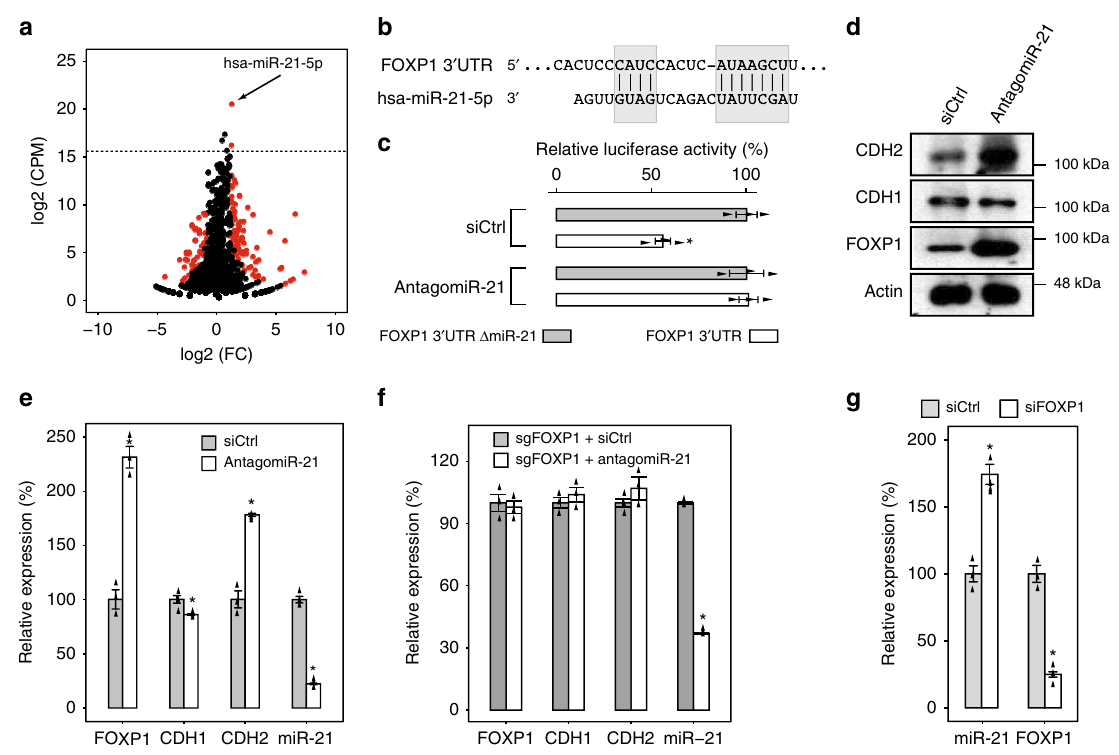
Fig. 2 FOXP1 and miR-21 form a double-negative feedback loop. a Volcano plot showing the differential expression of miRNAs at 96 h into TGF- β -induced EMT in A549 cells. The red dots represent miRNAs with a differential expression FDR < 0.05 and absolute log2-fold change> 1. The horizontal dotted line represents the log2(CPM) corresponding to 100 copies/cell. b Graph showing the sequence alignment of FOXP1 3 ’ UTR with miR-21-5p. c The results of the luciferase reporter assay were quanti fi ed (bar charts). d Immunoblotting analysis of the protein abundance of indicated genes in A549 cells during TGF- β - induced EMT after a speci fi c antagomiR was used to silence miR-21 expression. e Same as ( d ) for the qRT-PCR assay. f qRT-PCR analysis of the indicated genes in A549 cells during TGF- β -induced EMT after a speci fi c antagomiR was used to silence miR-21 expression, using A549 cells whose miR-21 binding site in FOXP1 has been mutated by CRISPR-Cas9. g A549 cells undergoing TGF- β -induced EMT were treated with a siRNA targeting FOXP1, and the impact on miR-21 expression was quanti fi ed using qRT-PCR. n = 3; error bars indicate the means ± s.d. * p < 0.01, determined using a two-tailed Student ’ s t test. Source data are provided as a Source Data fi